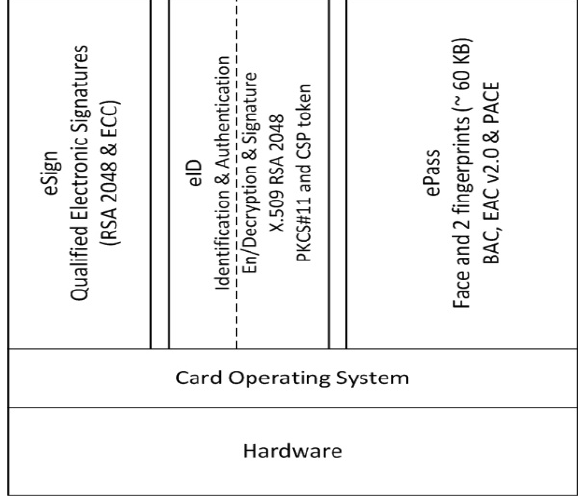
Fig. 1. National biometric ID card hosted